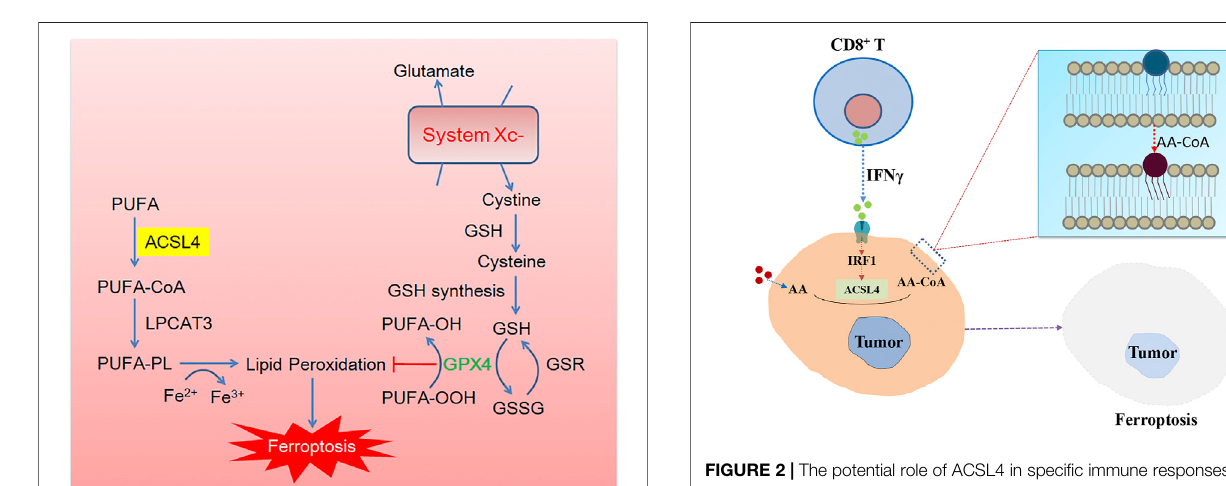
FIGURE 2 | The potential role of ACSL4 in speci fi c immune responses mediated by CD8 + T cells. IFN- γ secreted by CD8 + T cells stimulates ACSL4 and alters tumor cell lipid patterns, thereby increasing the binding of AA in C16 and C18 acyl-chain phospholipids. Lipid peroxidation then leads to ferroptosis of tumor